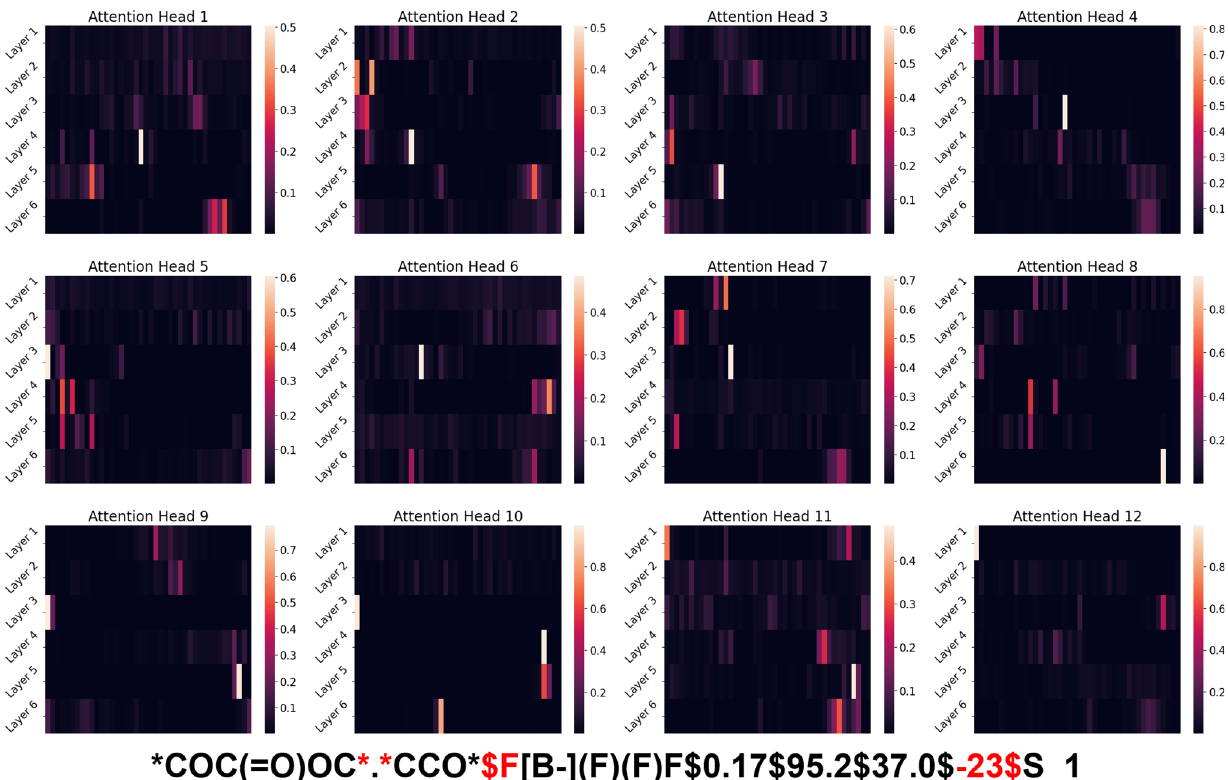
Fig. 6 Visualization of attention scores from fi netuned TransPolymer. The attention scores between the ‘ 〈 s 〉 ’ token and other tokens at different hidden layers in each attention head after fi netuning are visualized. At the bottom is the sequence used for visualization in which the tokens having high attention scores with ‘ 〈 s 〉 ’ are marked in